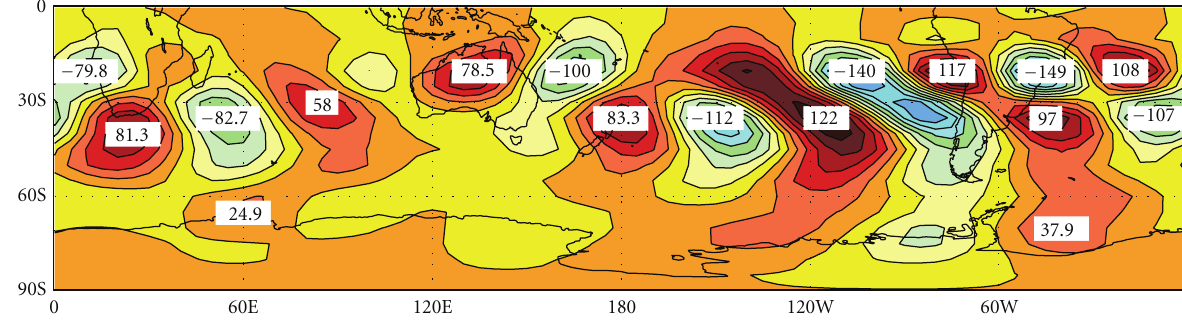
Figure 5: As in Figure 4(a) but for the SH midlatitude onset-of-blocking mode, mode 26, for the July 1997–2006 basic state.